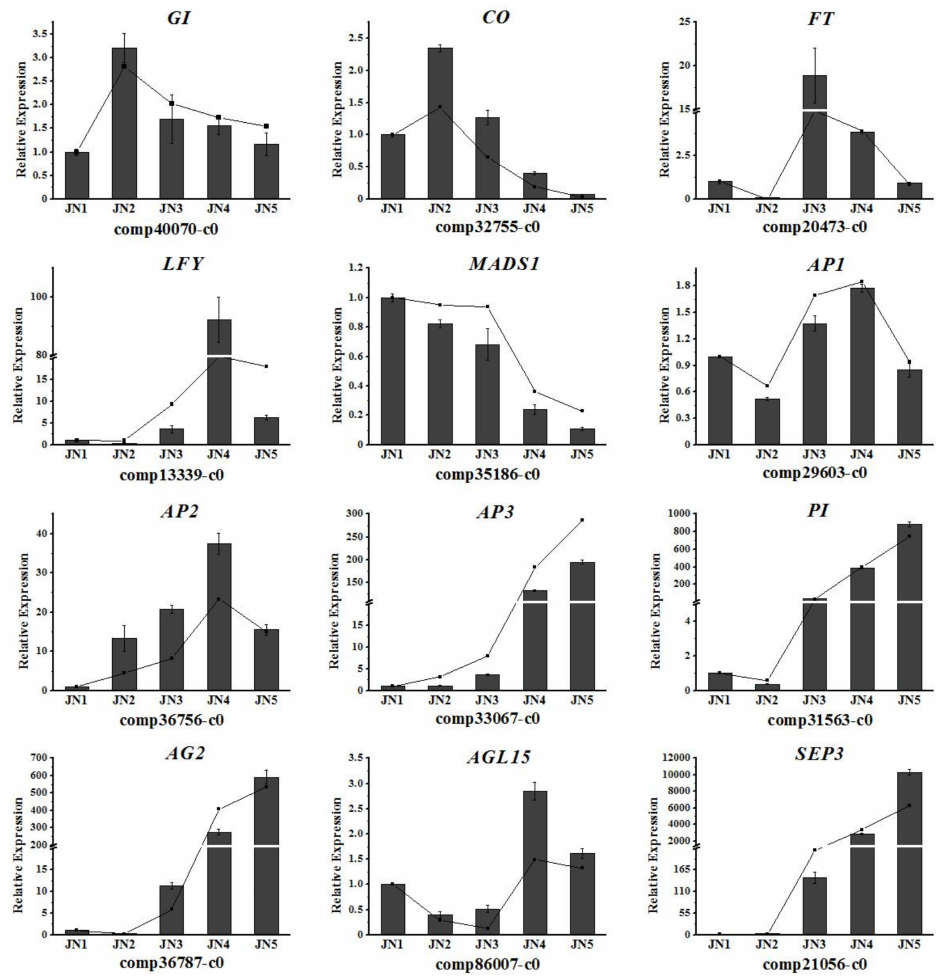
Figure 7. qRT-PCR analysis of the expression 12 DEGs. These 12 putative MADS-box family, AP2 family and circadian rhythm pathway genes were related to the formation of flower. The undifferentiated stage was used as a control group when calculating the relative expression quantity. Line were from the results of transcriptome data; column charts were from the results of